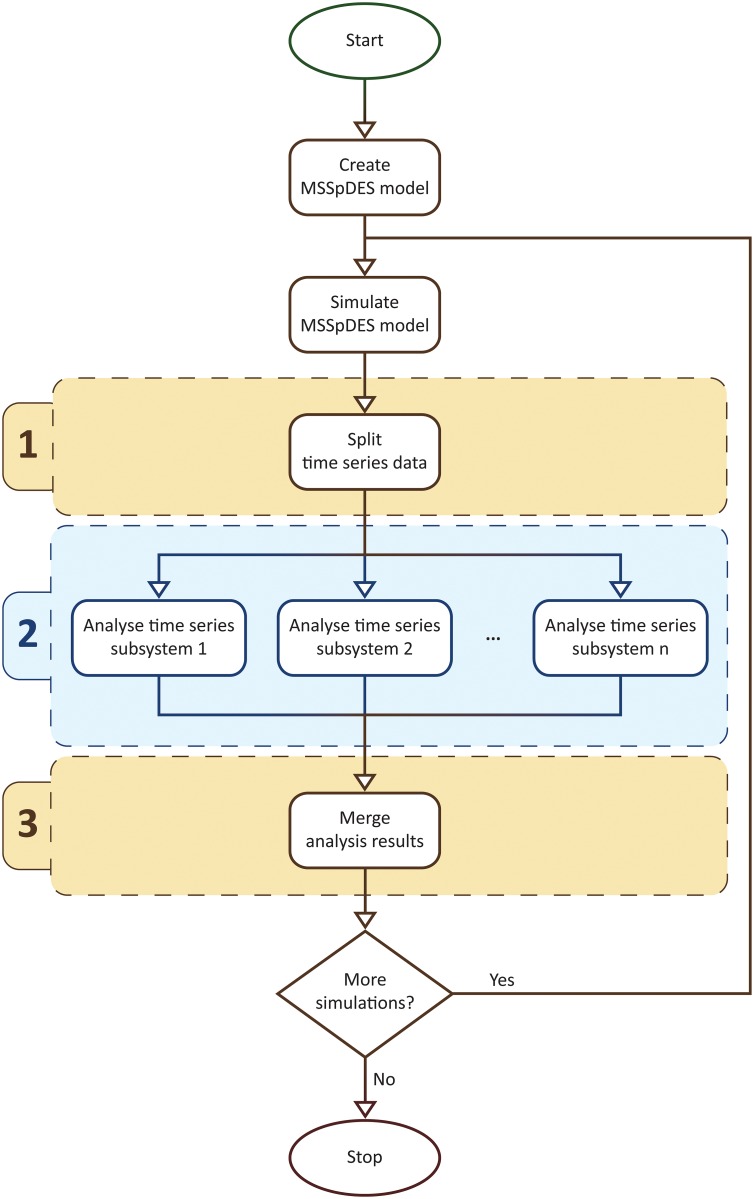
The multiscale spatio-temporal analysis workflow.An MSSpDES model of the system under consideration is constructed and simulated to generate time series data. This time series data is split up into subsets (1) such that each subset corresponds to a single subsystem and scale. The time series data subsets are passed to a uniscale spatio-temporal analysis module (2) which automatically detects, analyses and annotates spatial entities with their corresponding scale and subsystem. The results of the uniscale spatio-temporal analysis are then merged (3) such that spatial entities corresponding to the same time point are grouped together. If more simulations are required, a new time series dataset is generated, for which steps (1)–(3) are repeated.